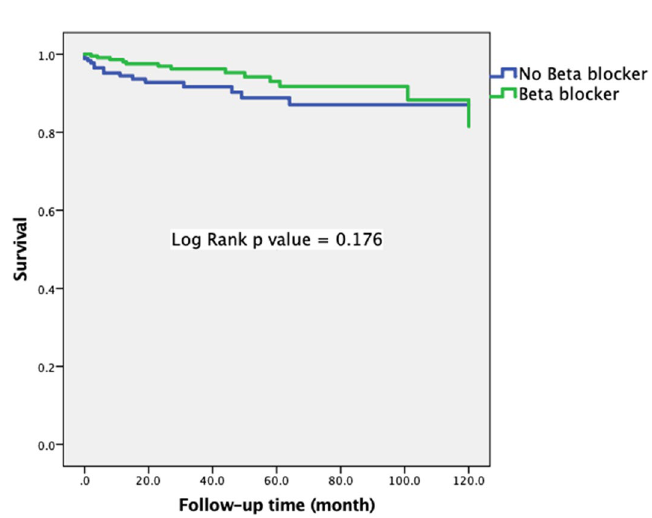
Figure 4. Kaplan–Meier curve within SADS according beta blocker